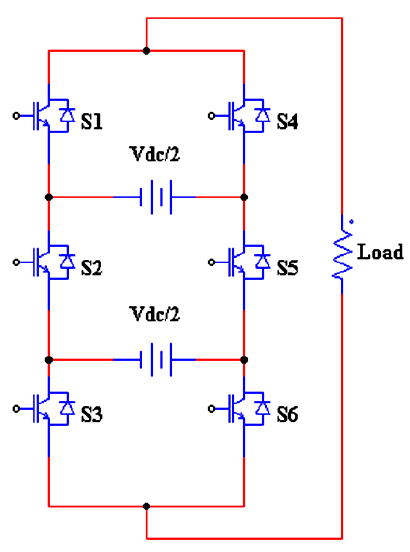
Figure 18. Circuit for modified MLI with minimum number of switches.